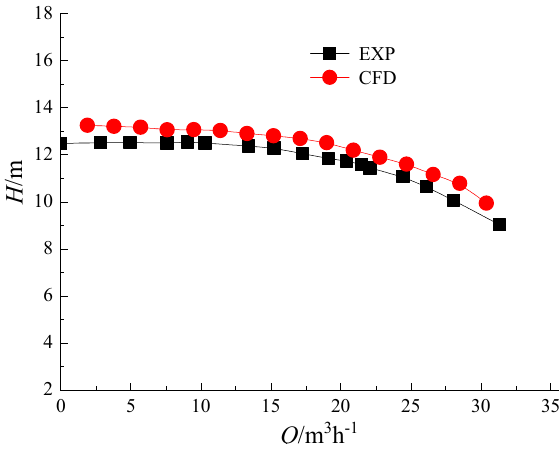
Figure 22. Comparison between experiment and simulation.